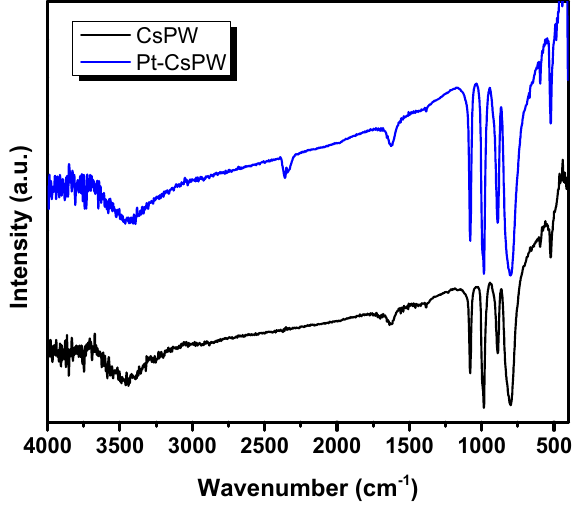
Figure 2. Fourier transform-infrared (FTIR) spectra of Pt-CsPW and neat CsPW.